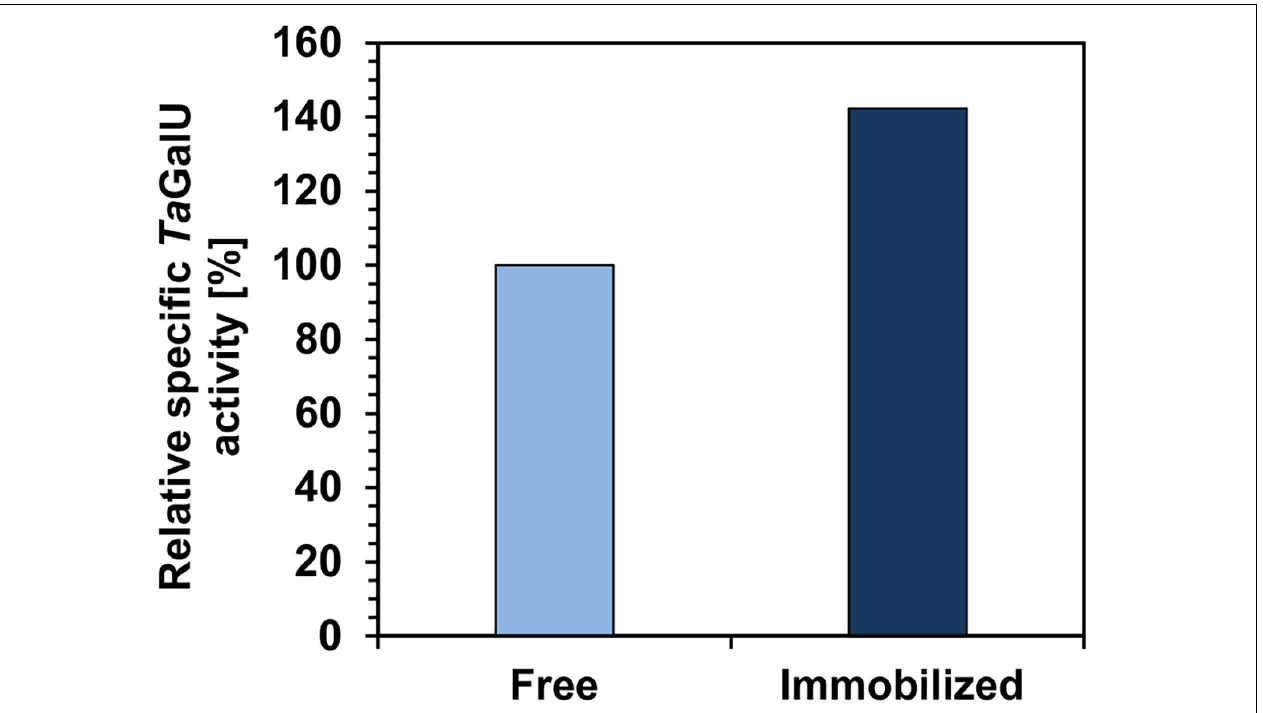
FIGURE 4 | Relative specific activities of free Ta GalU and immobilized Ta GalU on MCF. Reaction solution contained 2 mM UTP, 2 mM G1P, 3 mM MgCl 2 , 50 mM Hepes buffer, pH 7.0, 0.3106 µ g mL - 1 Ta GalU. Reaction was carried out at 50 ◦ C in 3 mL reaction volume. Free Ta GalU activity (initial: 1016 U mg − 1 and after 1.5 years of storage at 4 ◦ C: 66 U mg − 1 ) was set to 100% (66 U mg − 1 ). Enzyme activity of Ta GalU was measured directly before and after immobilization considering the determined amount of enzyme in each assay. Immobilized enzyme used herein was linked to the MCF carrier via amino group at pH 6.7.